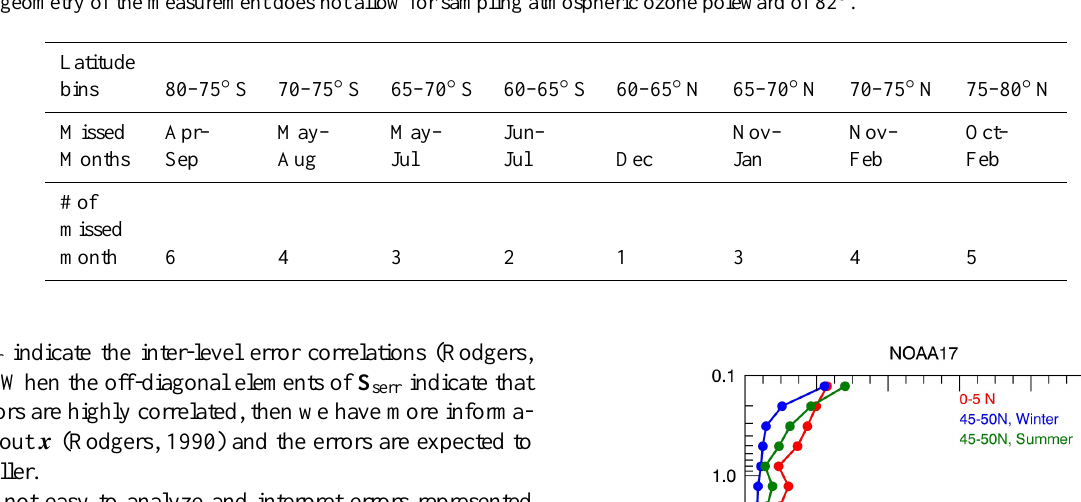
Table 2. Months of the year for high latitude regions when the SBUV measurements are not possible (or very limited) due to high SZA (polar night conditions). Note, between 60 ◦ S and 60 ◦ N the SBUV obtains measurements over the whole year. The orbit of the SBUV satellites and the geometry of the measurement does not allow for sampling atmospheric ozone poleward of 82 ◦ .